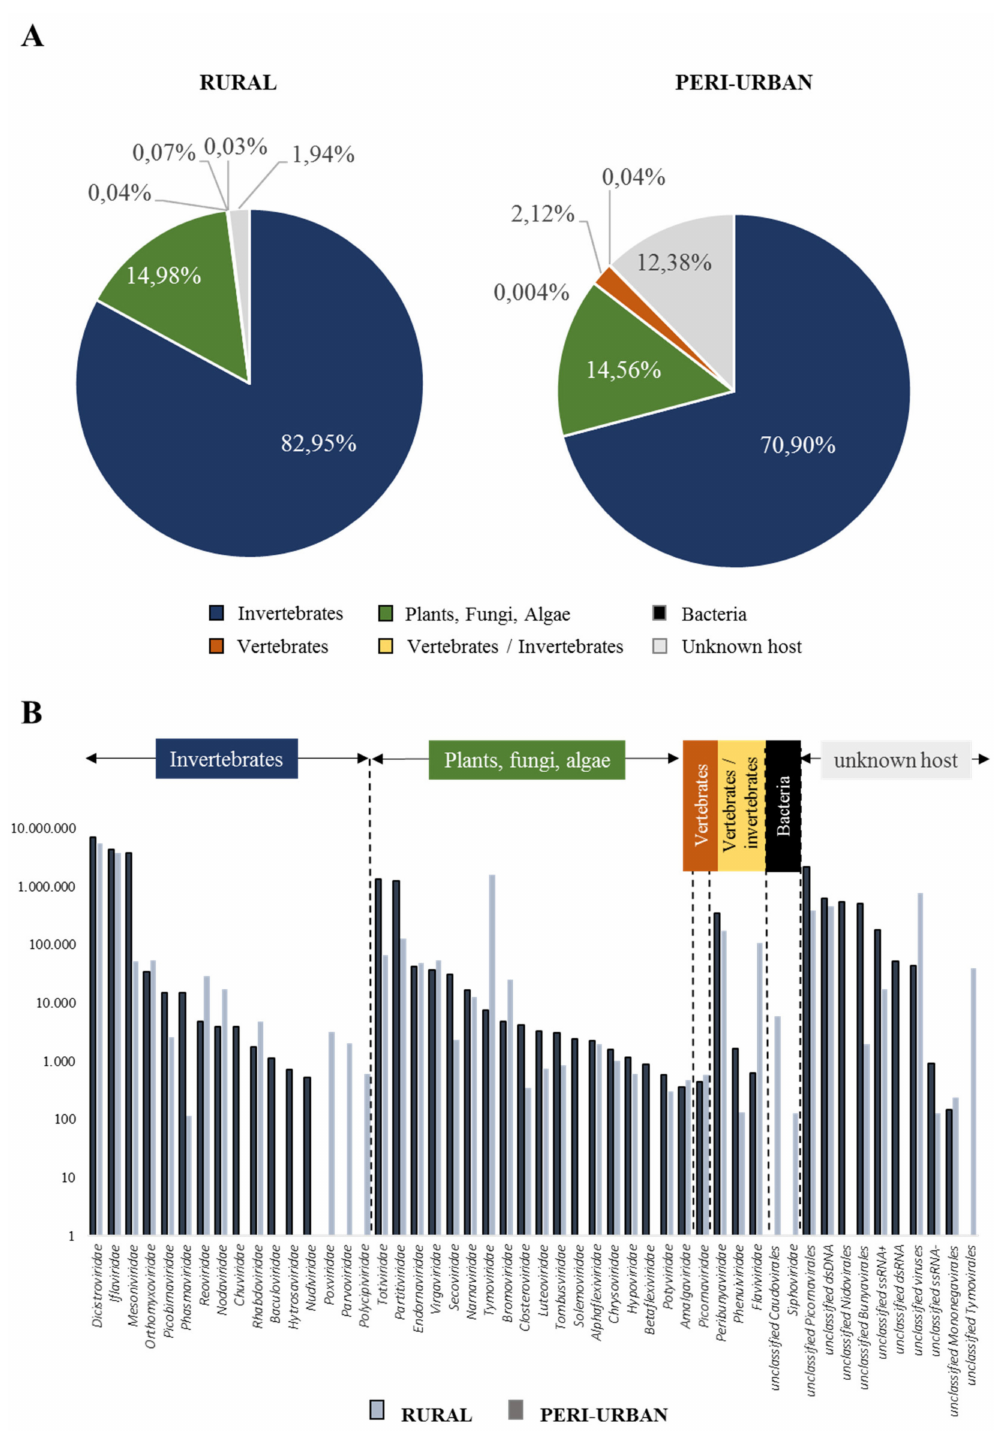
Figure 1. Overview of viral composition of honey-baited FTA cards. ( A ) Shows the proportion of viral reads classified by host type. Proportions of bacteria and vertebrate / invertebrate are too small to be seen in the figure. ( B ) Abundance in nucleotides of each viral family estimated by summing sequence length in nucleotides weighted by the k-mer coverage of each